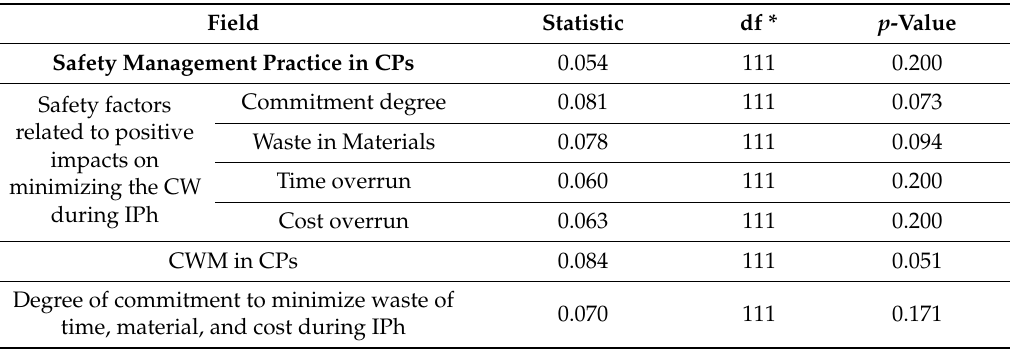
Table 4. Results of the KS test of normality.